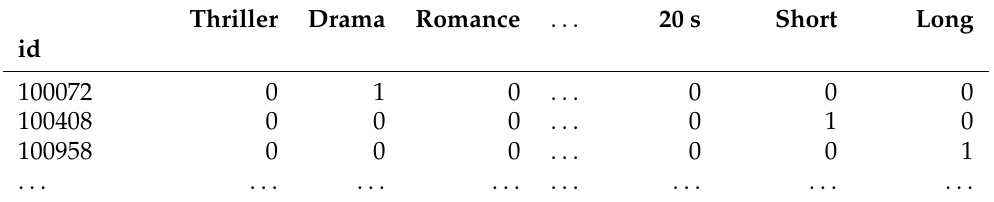
Table 2. Dataframe movies, including all the movies with all movie features. The shape is (2831, 412), where 2831 is the number of movies, and 412 is the number of